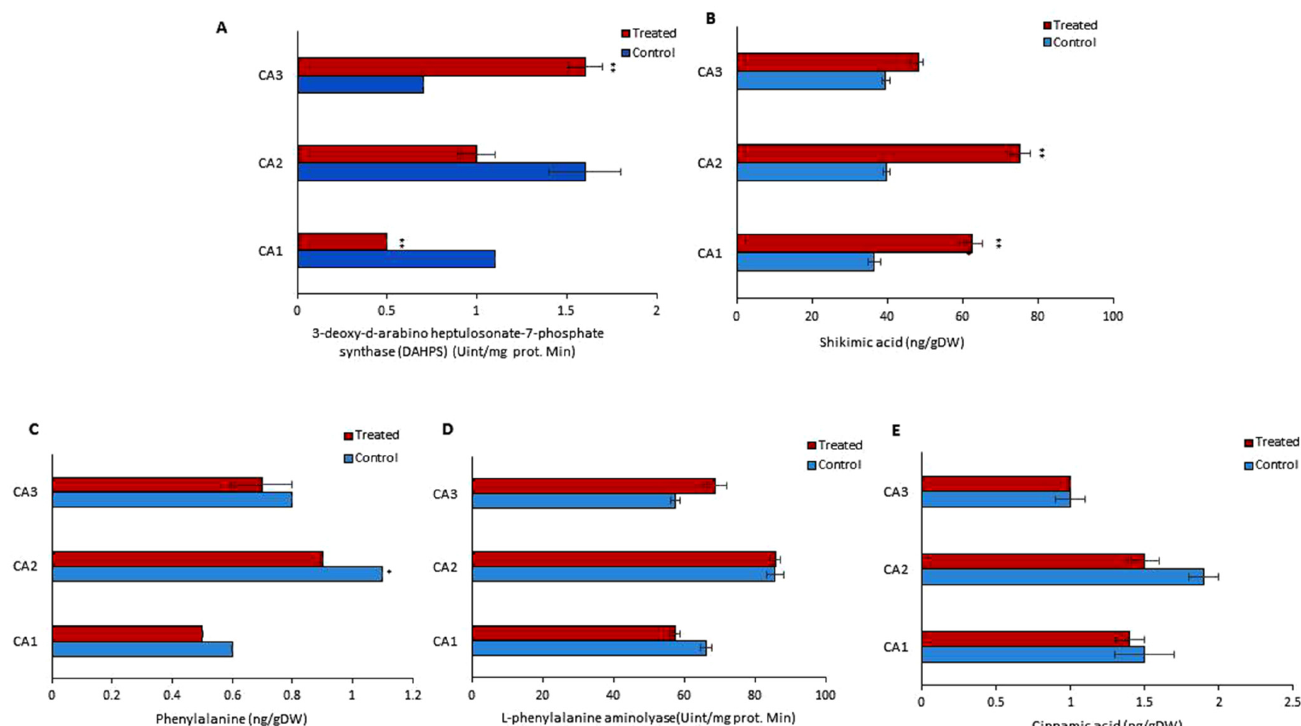
Figure 3. Effects of molybdenum (Mo) treatment on phenol synthesis pathway. ( A ): 3-deoxy-d-arabino heptulosonate-7- phosphate synthase (DAHPS) activity. ( B ): Shikimic acid level. ( C ): Phenylalanine. ( D ): L-phenylalanine aminolyase activity. ( E ): Cinnamic acid content. Control; without treatment, Treated; Mo treatment. CA1; Canavalia ensiformis var. ladiate , CA2; Canavalia ensiformis var. ladiate Ricker , CA3; Canavalia ladiate var. alba Hisauc . The bars above mean indicate ± standard deviation (S.D) of three independent replicates ( n = 3). Asterisks (*) show the level of significance, * p < 0.05, ** p < 0.01.